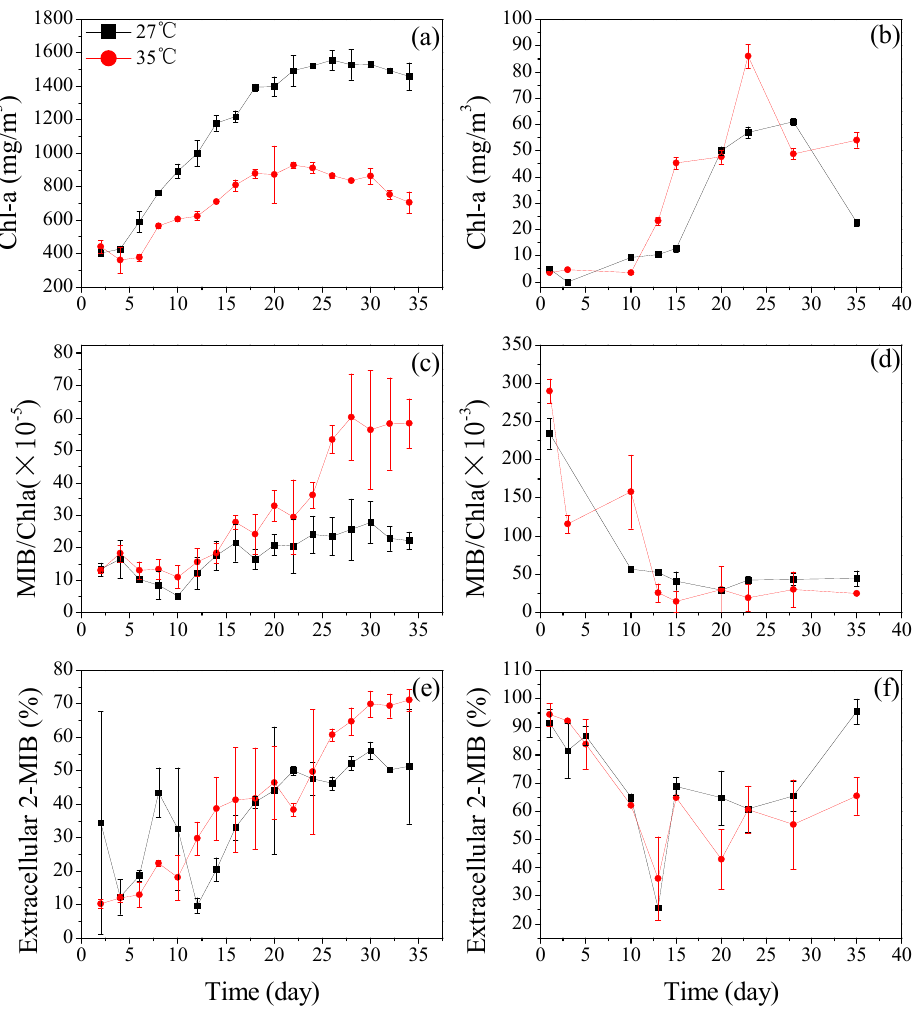
Figure 4. The variations of Chla, 2-MIB-producing potential, and extracellular 2-MIB proportion for Dolichospermum spiroides ( a , c , e ) and Planktothrix sp. ( b , d , f ). 2-MIB-producing potential was shown by 2-MIB/Chla.